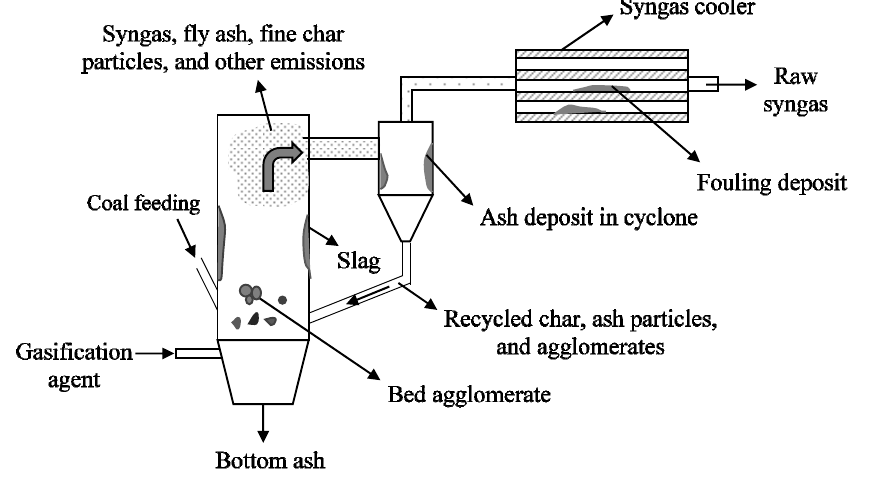
Figure 5. A pictorial representation of bed agglomeration, and ash deposition in a fluidized bed gasifier. Table 2. Effect of operation parameters on agglomeration and defluidization [25,49,52].